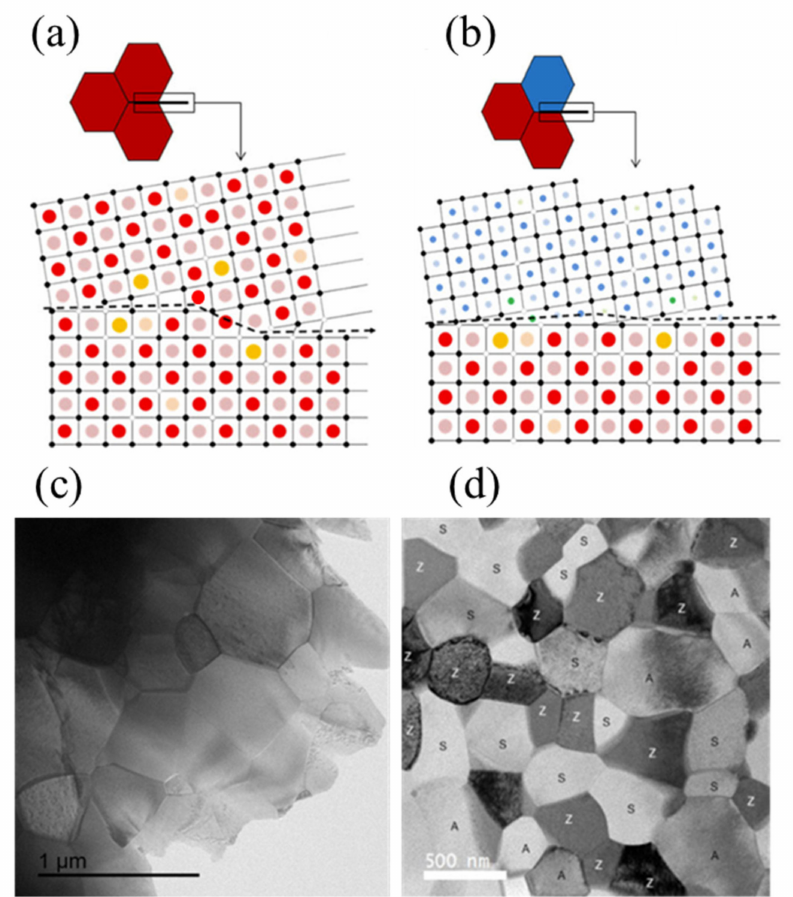
Figure 2. Schematic diagrams of interface between ( a ) same material (GBs) and ( b ) different materials (HIs) at atomic scale ( c ) BF-TEM micrograph of GBs in a polycrystalline Gd/Pr co-doped CeO 2 ( d ) BF-TEM micrograph of HI and GBs in a polycrystalline MgAl 2 O 4 , YSZ and Al 2 O 3 multiphase oxide. Grains in red and blue in ( a , b ) are depicting different materials with different chemistry